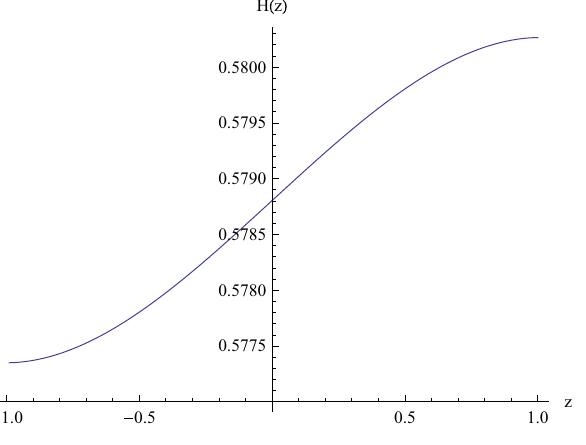
Fig. 3 H ( z ) giveninEq.(5.12)from z = 1to z = − 1with ϕ( 1 ) = 0 . 1, β( 1 ) = 0 . 01, and κ = 1. The asymptotic line is H ( z ) = ≈ 0 . 3 Fig. 4 and (cid:24) m 0